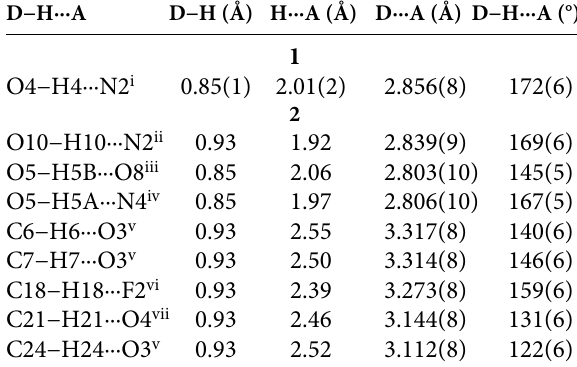
Table 2. Selected bond distances (Å) and angles (°) for the complexes 1